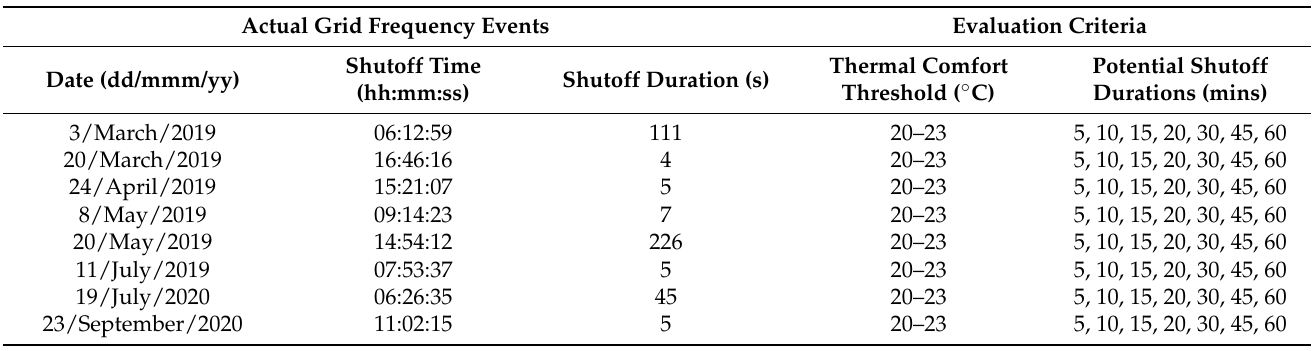
Table 4. Table of scenarios outlining previous actual grid frequency events, including their dates, shutoff times and durations, in addition to the thermal comfort threshold and potential shutoff durations for